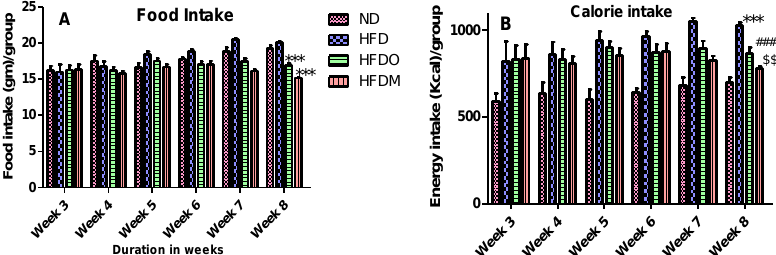
7 of 20 Figure 3. High Performance Liquid Chromatography ( HPLC) chromatogram of ( A ) MESK, ( B ) Gallic acid, and ( C ) Overlay of (A) and (B). HPLC analysis confirmed the presence of Gallic acid as a major bioactive agent in MESK. 3.2. Effects of Mangifera Indica on Body Weight, Food, and Energy Intake